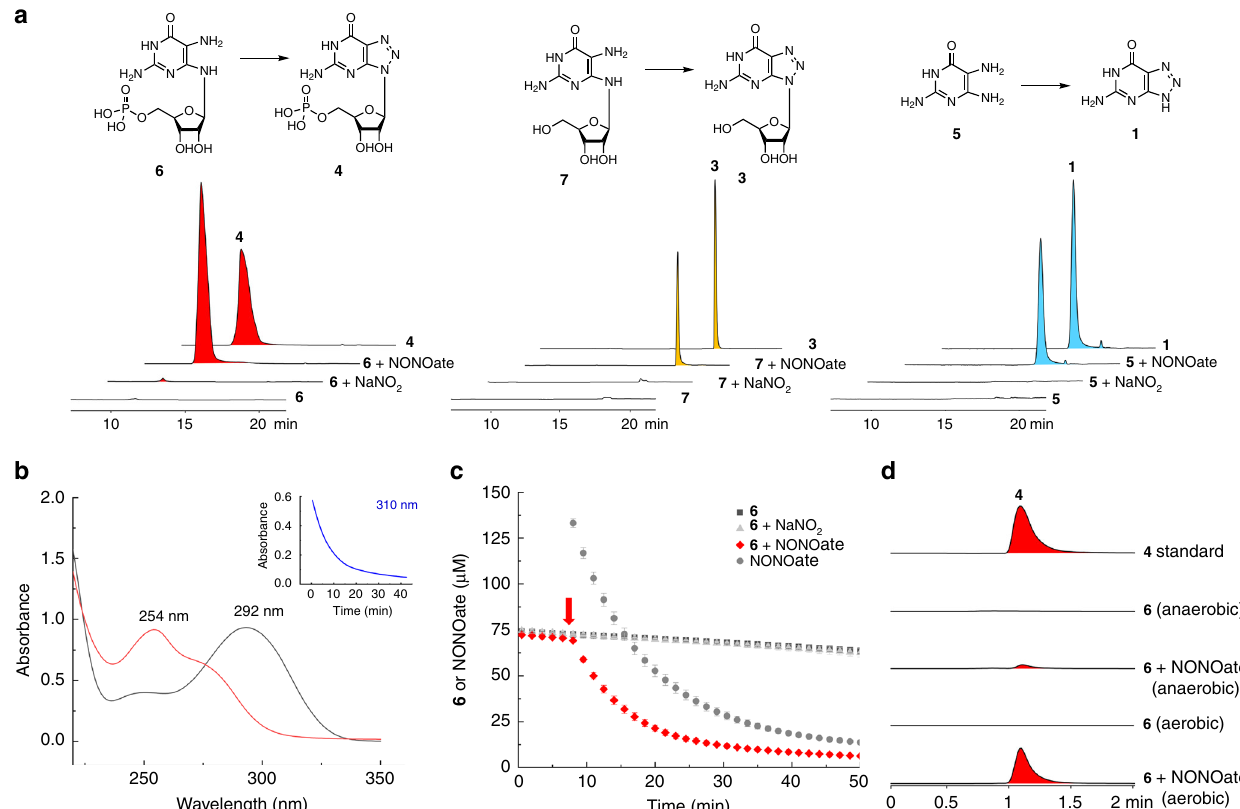
Fig. 4 Non-enzymatic triazole assembly. a LC-MS analysis of the reaction mixtures of 5 , 6 , or 7 with NaNO 2 or DEA NONOate. The EICs for 4 ( m / z 363, [M − H] − ), 3 ( m / z 283, [M − H] − ), and 1 ( m / z 151, [M − H] − ) are presented. Compound 5 , 6 , or 7 (0.5 mM) are incubated with DEA NONOate (1 mM) or sodium nitrite (1 mM) at 30 °C for 1 h before LC-MS analysis. Authentic 1 , 3 , 4 were used as analytical standards. b Change of 6 (75 μ M, black line) absorption spectra upon the addition of NONOate (150 μ M) in 50 mM phosphate buffer (pH 7.4) at 25 °C. The red trace was collected 1 h after the addition of NONOate. The absorbance at 310 nm was monitored with a 1.5-min time interval (as shown in the insert fi gure). c Time-course study of the reaction of 6 (75 μ M) with NONOate (150 μ M) or nitrite (150 μ M). Red arrow indicates the time point when NONOate or nitrite was added. Values are means of three independent experiments ± SD. Source data are provided as a Source Data fi le. d LC-MS analysis of the reaction mixtures of 6 (75 μ M) and NONOate (1 mM) prepared anaerobically and aerobically. The EICs for 4 ( m / z 363, [M − H] − ) are presented. Three independent tests were